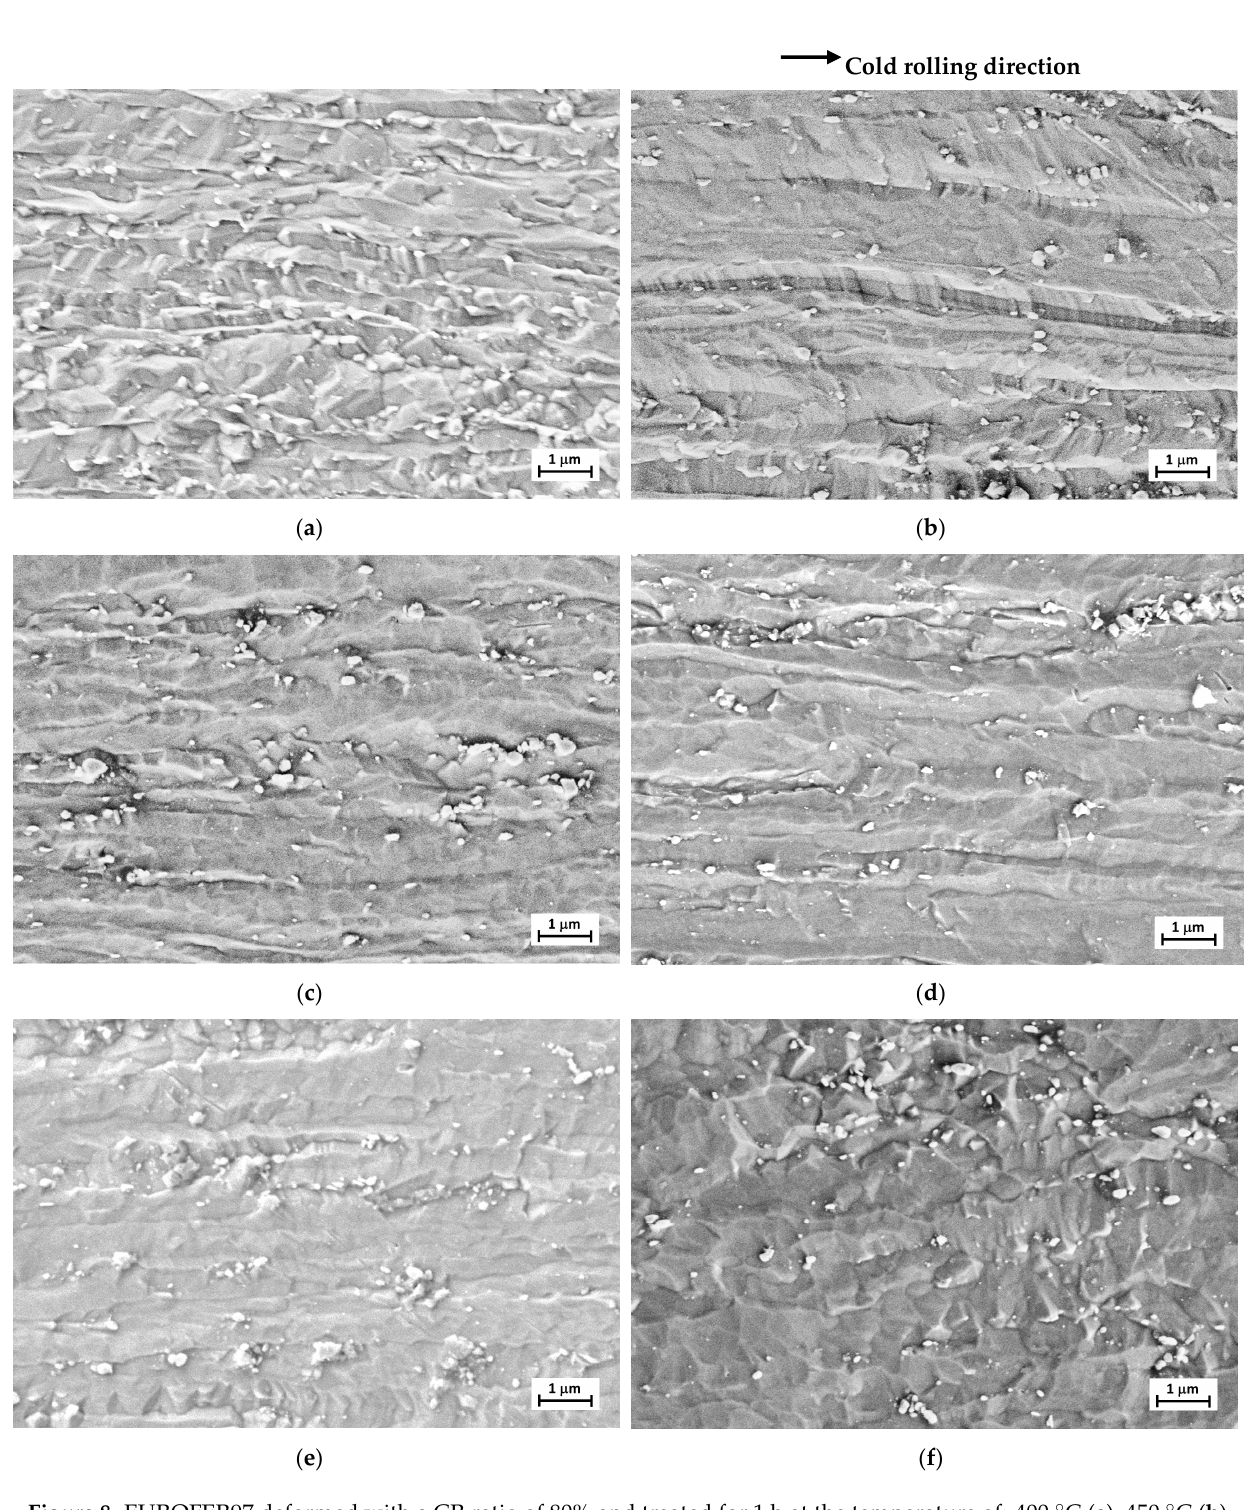
Figure 8. EUROFER97 deformed with a CR ratio of 80% and treated for 1 h at the temperature of: 400 °C ( a ), 450 °C ( b ), 500 °C ( c ), 550 °C ( d ), 600 °C ( e ), 650 °C ( f ).